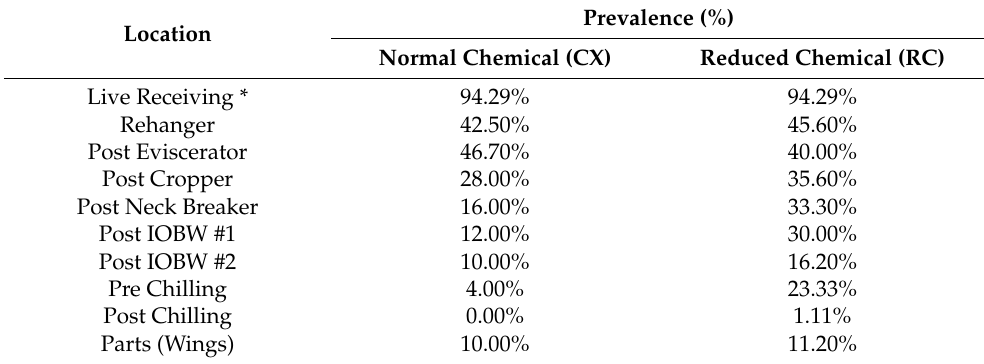
Table 5. Prevalence of Salmonella spp. at each Sampling Location for each Treatment: Normal Chemical (CX) and Reduced Chemical